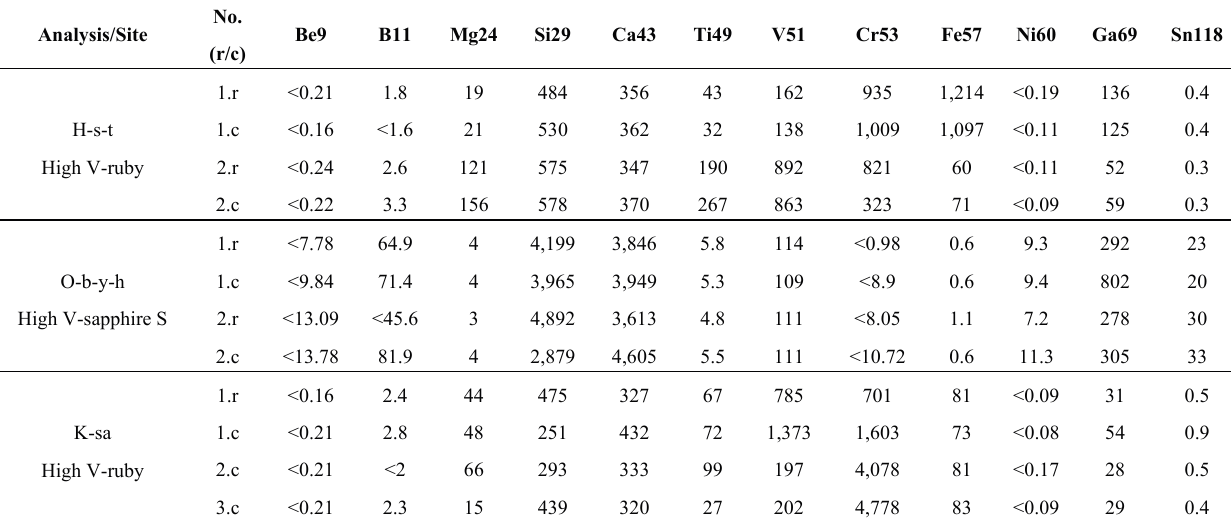
Table 2. Multi-element LA-ICP-MS analyses, Mogok corundum. Trace element values (ppm) for the samples plotted in geochemical diagrams (Figures